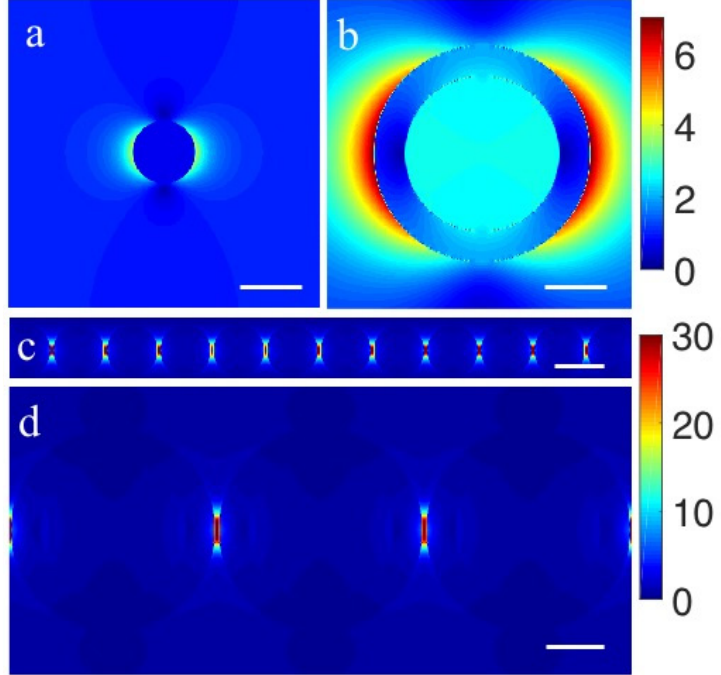
Figure 5. Local electric field distributions of ( a ) Au NPs, ( b ) Au–Ag alloy HNPs, ( c ) Au NCs and ( d ) Au–Ag alloy HNCs, respectively. All scale bars are 20 nm.